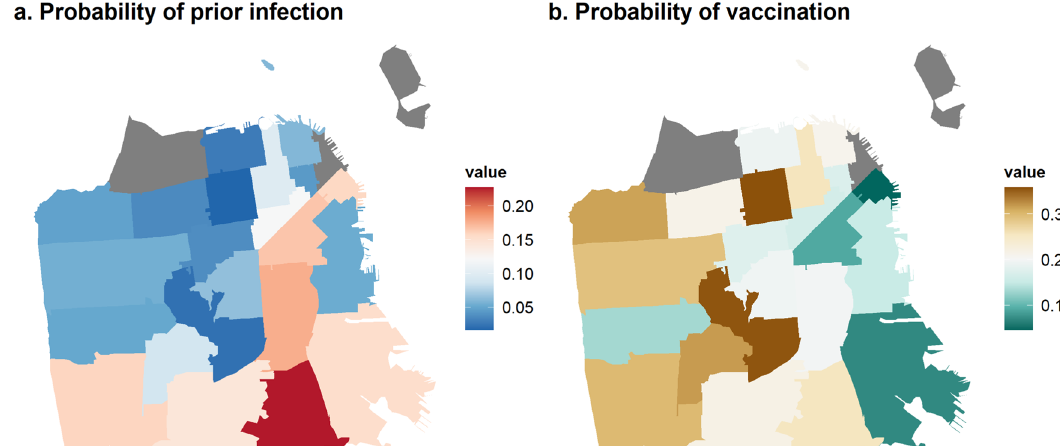
Fig. 3 Maps showing geographic disparities in SARS-CoV-2 within San Francisco. Maps show a estimated probability of prior infection and b probability of vaccination by zipcode in San Francisco, as of February 2021.